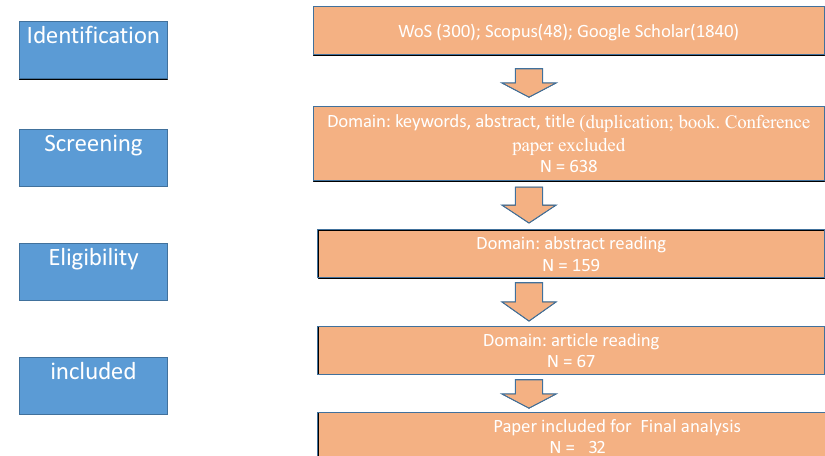
Fig. 1 PRISMA diagram for the overall screening procedure. An overview of the overall screening procedures as well as the work fl ow associated with selecting relevant material. At the beginning of the process, a total of 2188 records were discovered from the databases. After eliminating gray literatures, duplicated papers, book and book chapters and conference papers, the number of articles maintained for further title reading and abstract review was decreased to 632. Following this, only 159 papers met the eligibility requirements for additional abstract reading and main body skimming. Out of that, 67 remained to be read in their entirety. During the main body reading, articles 32 without content pertaining either to teachers ’ professional development or student achievement were excluded manually. At last, 32 papers met eligibility requirements for SLR study